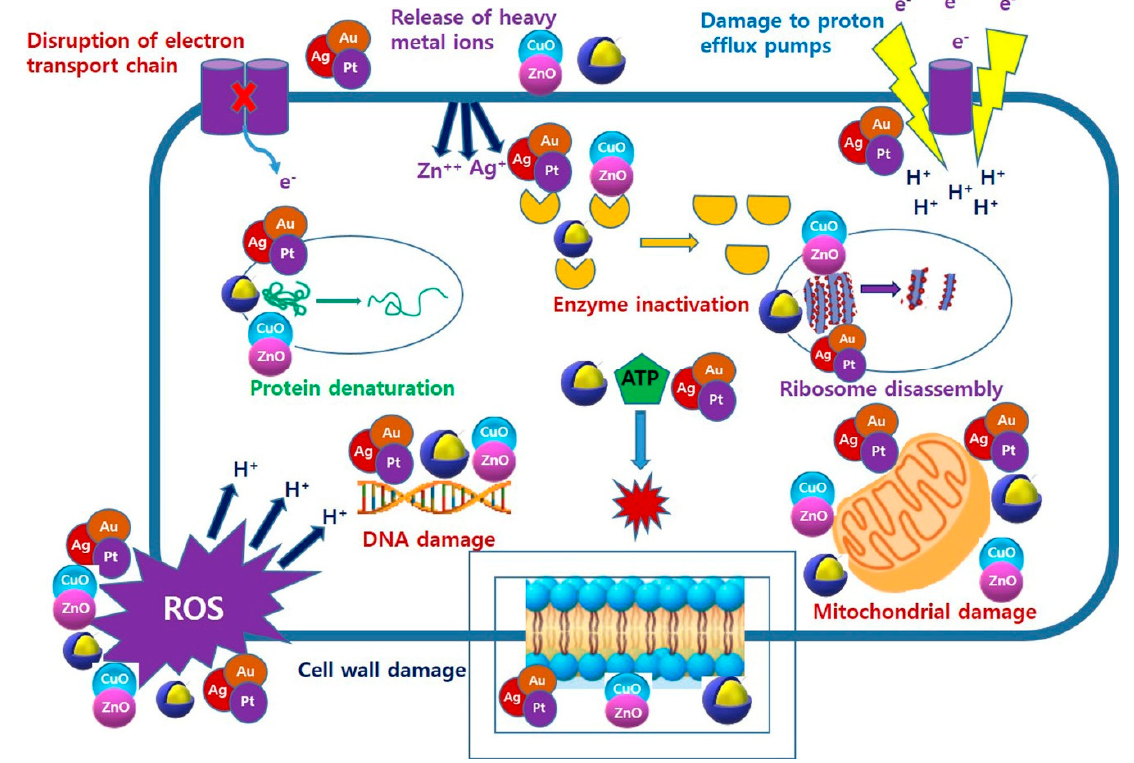
Figure 2. Antibacterial mechanism of multimetallic NPs.